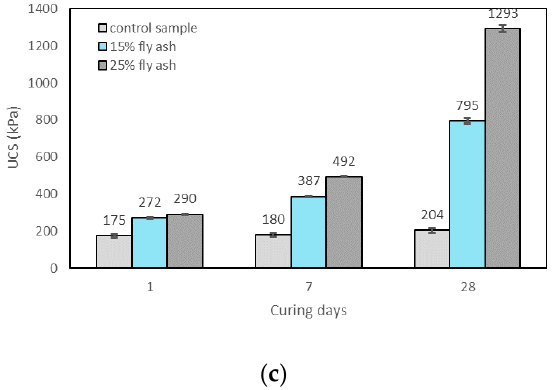
Figure 7. Effects of curing times on the UCS of the control sample: ( a ) soils stabilised with fly ash; ( b ) soils stabilised with alkali-activated fly ash with an M+ of 12% and an SM of 1.25; ( c ) soils stabilised with alkali-activated fly ash with an M+ of 16% and an SM of 1.25.